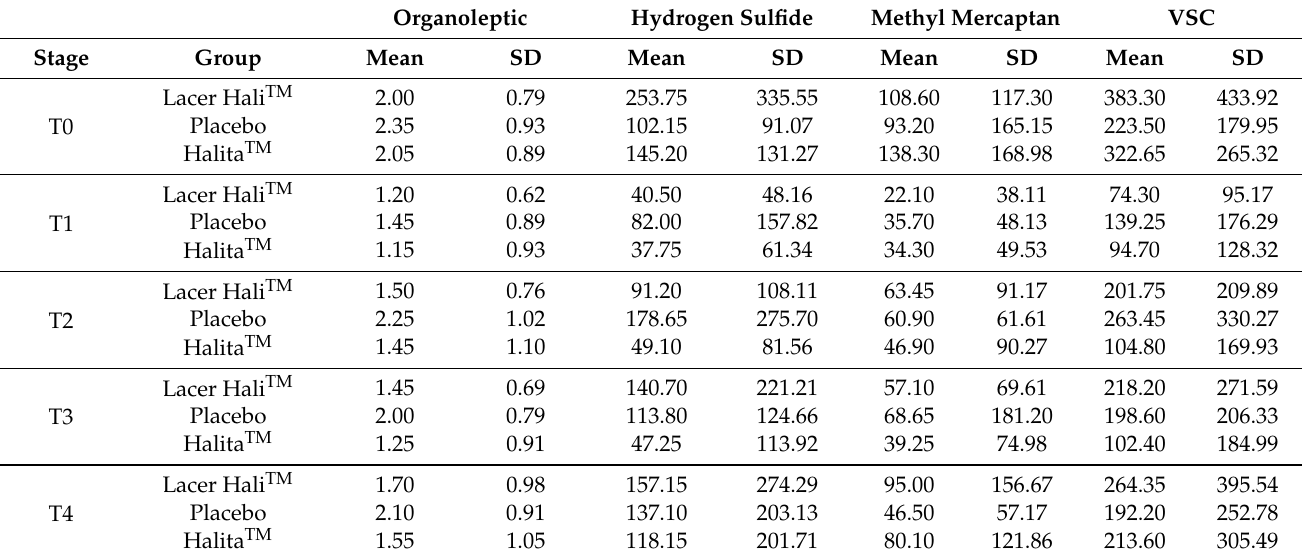
Table 1. Descriptive statistics of the evaluation of odors and the concentrations of hydrogen sulfide, methyl mercaptan, and VSCs.